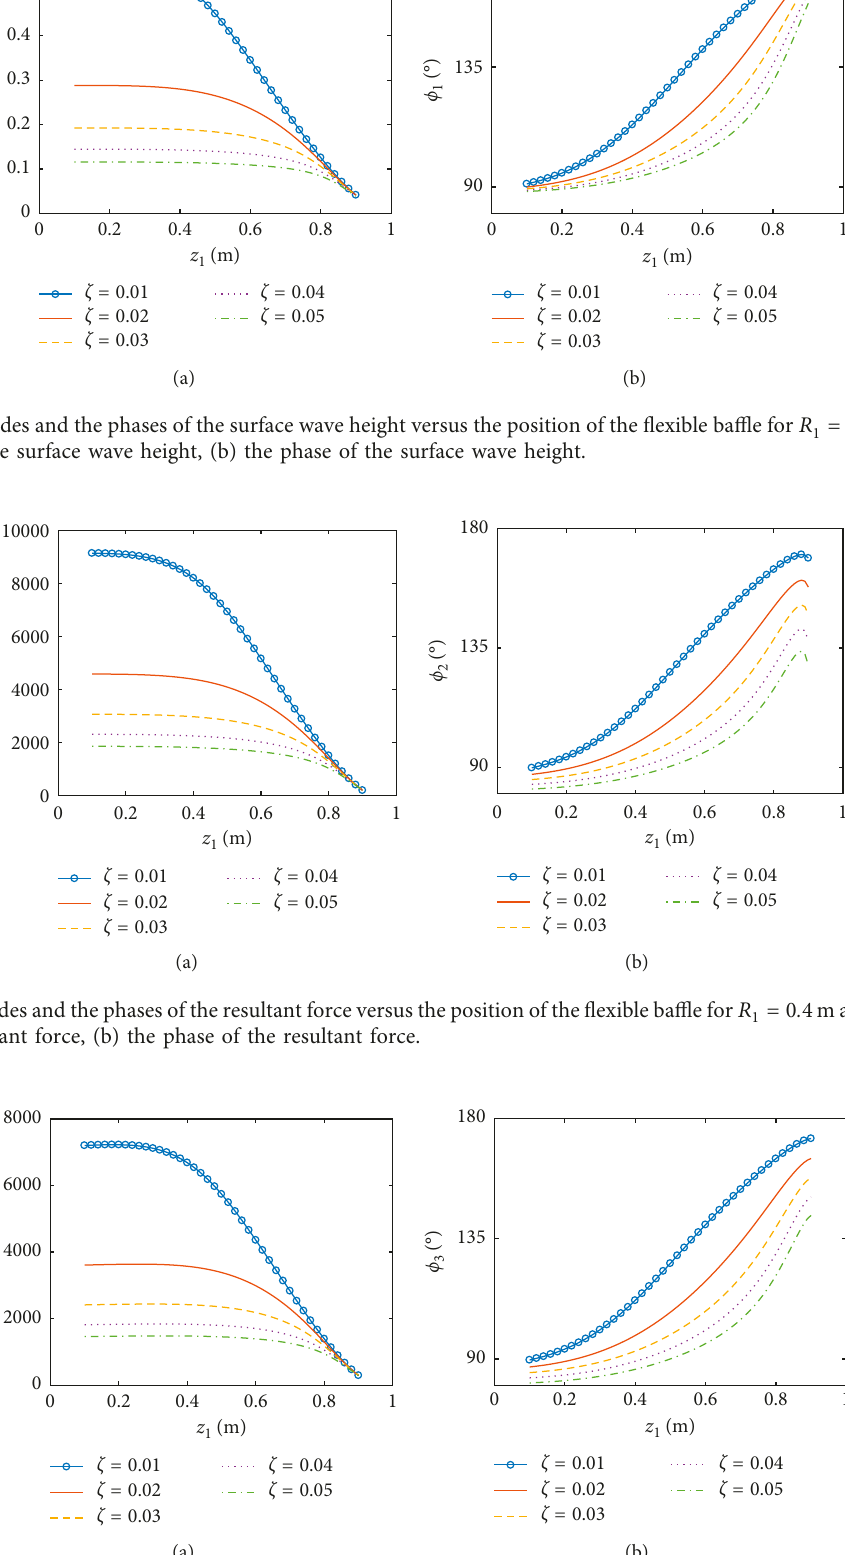
� 0 . 4m and τ � 2mm. (a) the 1